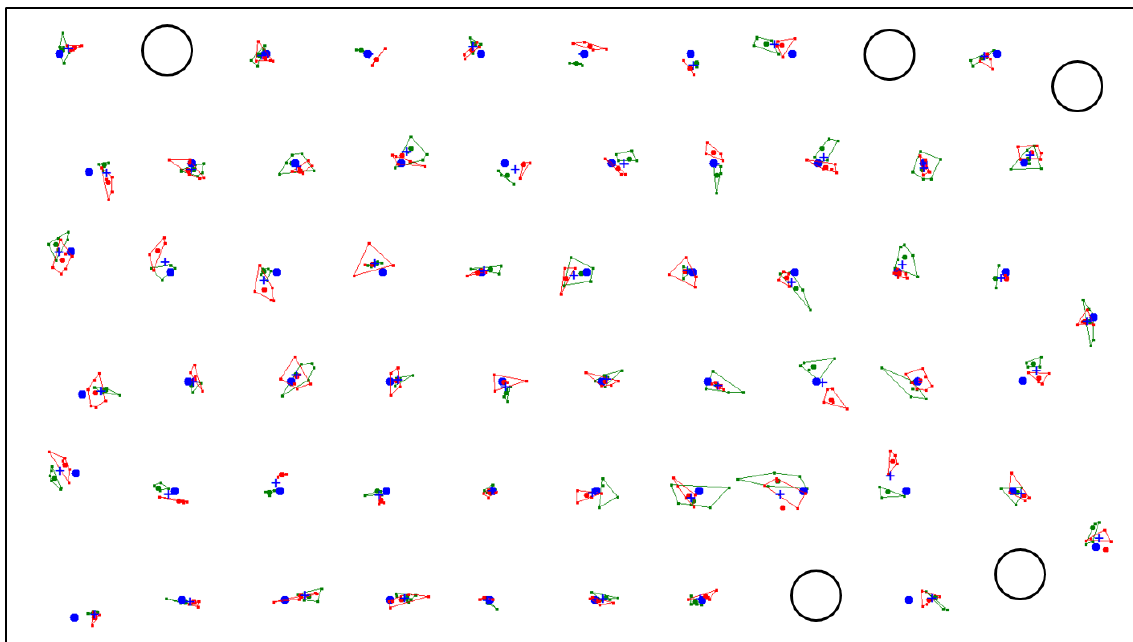
Figure 2. Calibration points with accompanying gaze data samples as captured with a horizontally moving target. Missing points marked with circles.